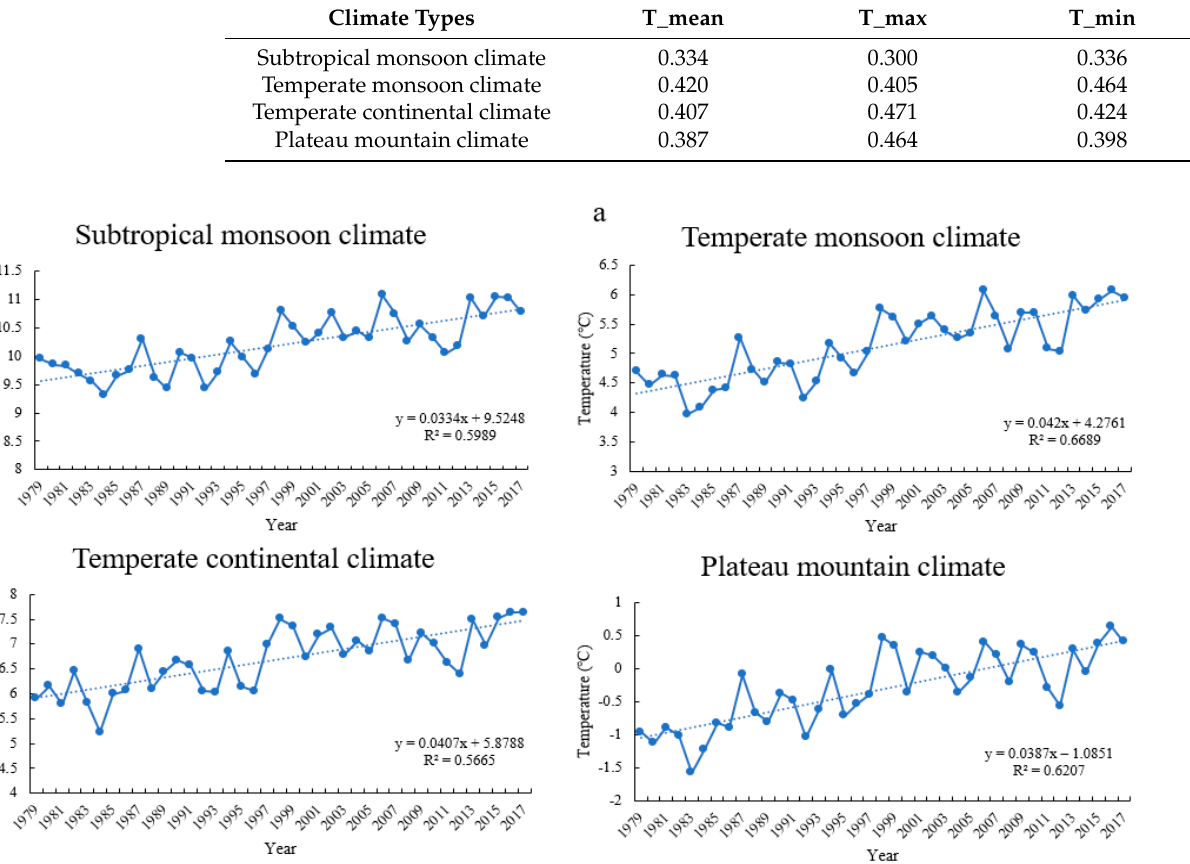
Table 3. Temperature increasing rates at different periods for the four different climate zones within Gansu Province at each period (°C/10a).